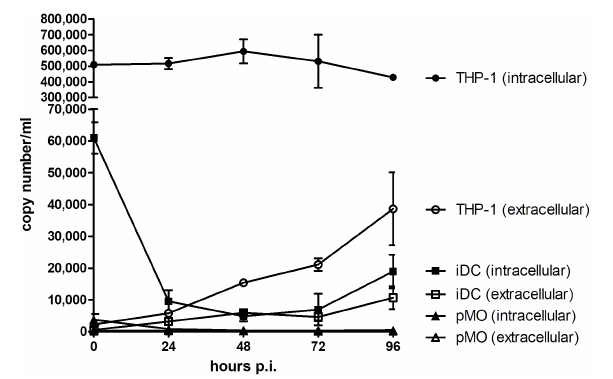
FIGURE 1 | Evaluation of NiV replication kinetics in iDC, pMO, and THP-1 infected with NiV. The extracellular and intracellular NiV N copy numbers were determined by real-time qPCR from 0 to 96 h p.i. Values are the average of two technical replicates and error bars indicate one standard deviation. Data is representative of two biological